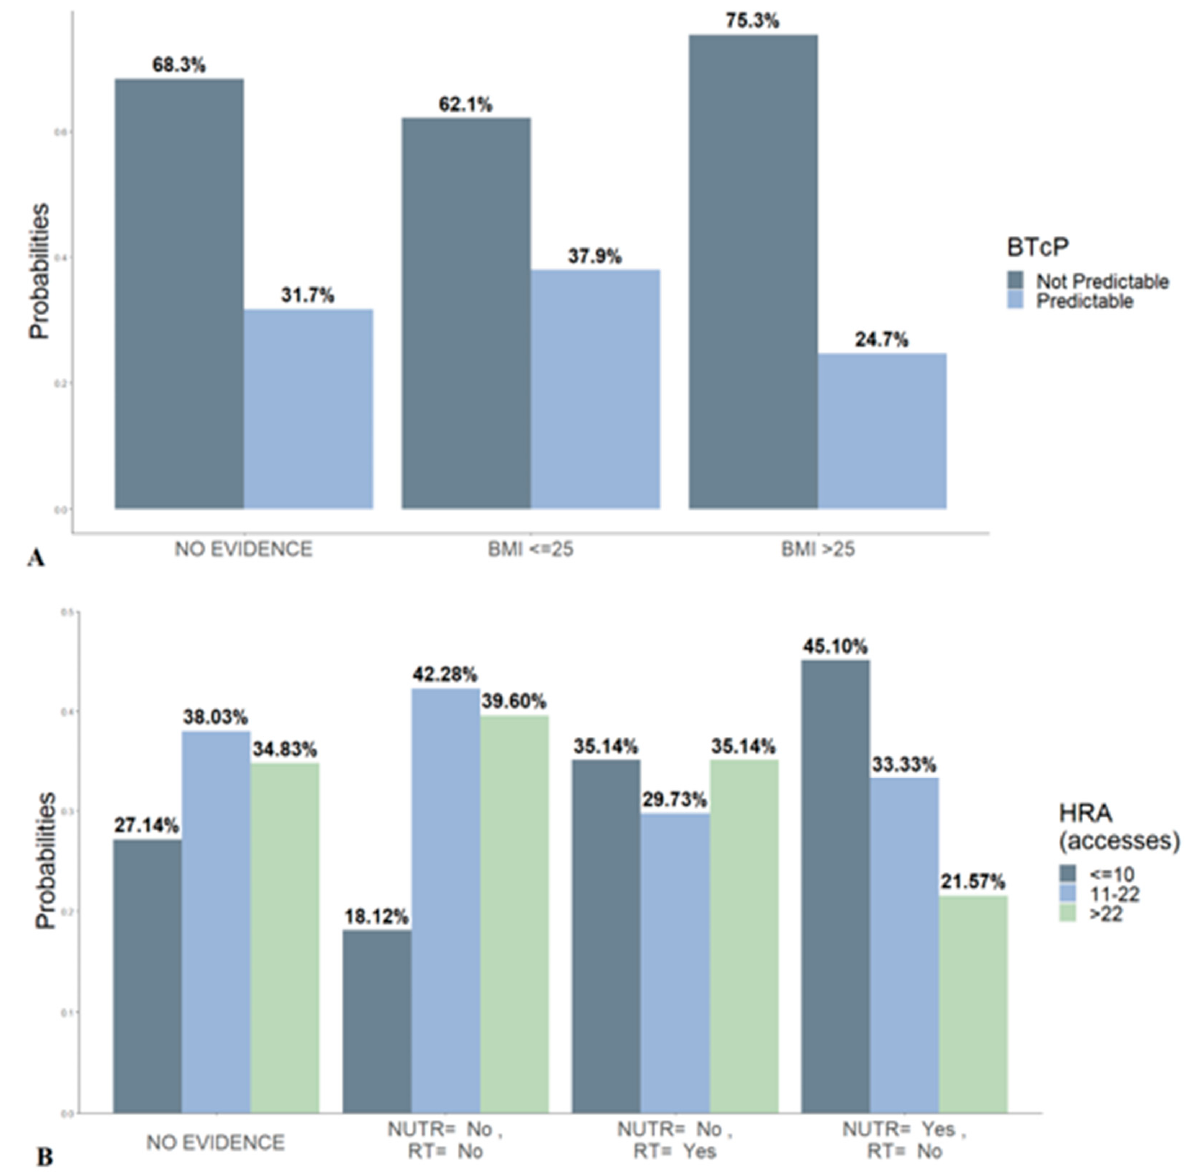
Figure 3. Conditional probabilities for BTcP ( A ) and hospital readmission ( B ). Bayesian inference on nutritional support and radiotherapy. Marginal values are overall data without variables condi- tioning. Abbreviations: BTcP, breakthrough cancer pain; RT, radiotherapy; NUTR, nutritional sup- port; HRA, hospital readmission.